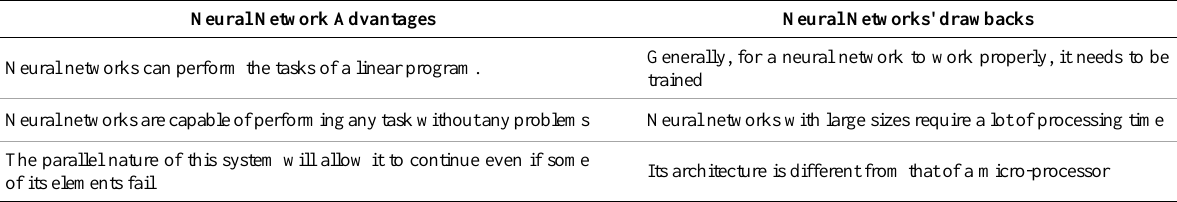
Table 1. A Comparison of the Advantages and Disadvantages of Neural Networks